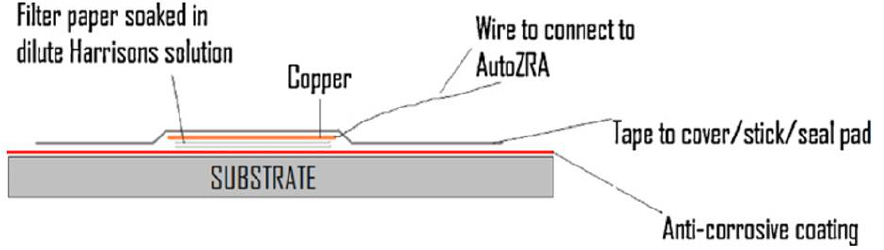
Figure 12. An illustration of the surface-attached ENM montage Reprinted with permission from ref. [94]. Elsevier, 2008.